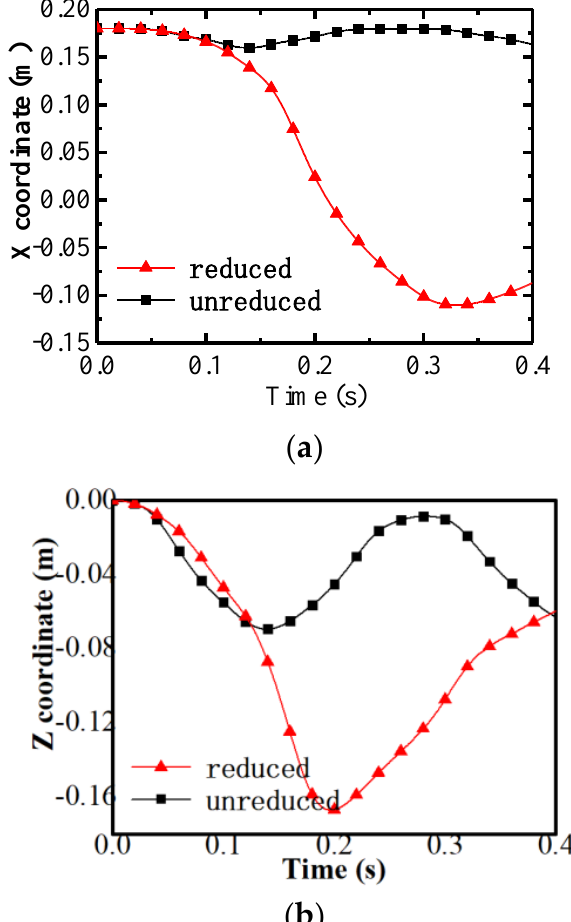
Figure 4. The coordinate of point P based on the Yeoh model. ( a ) X coordinate. ( b ) Z coordinate.